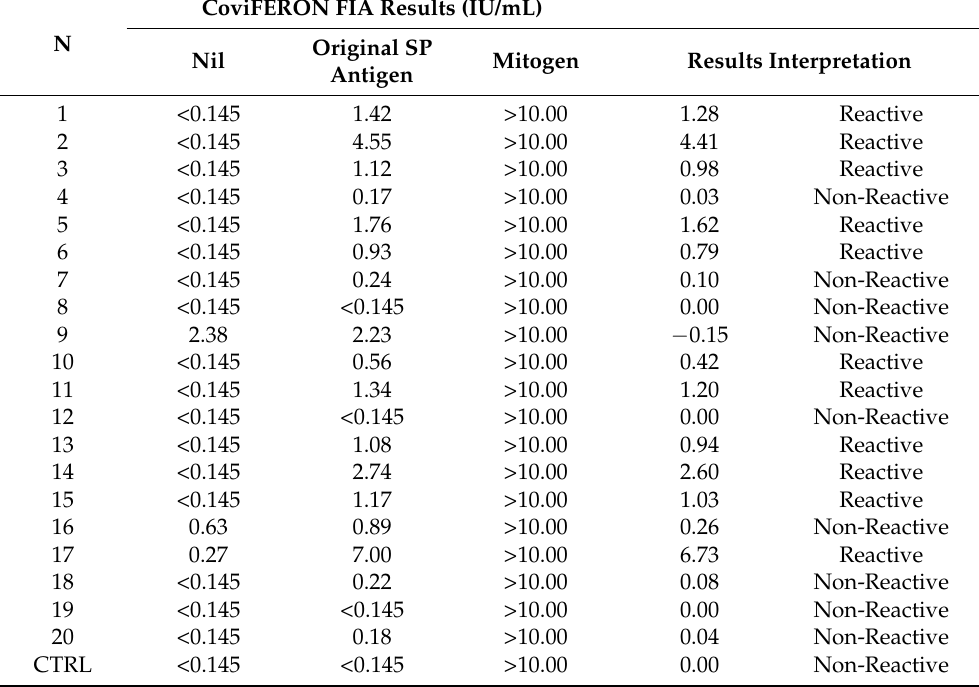
Table 2. The table shows the CoviFERON FIA results of the 20 samples previously analyzed by multiparametric flow